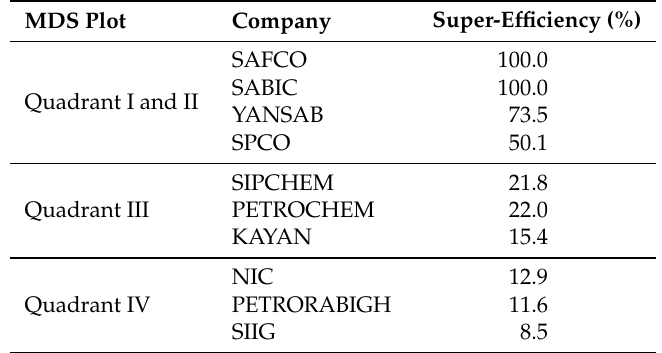
Table 4. Output from DEA and MDS